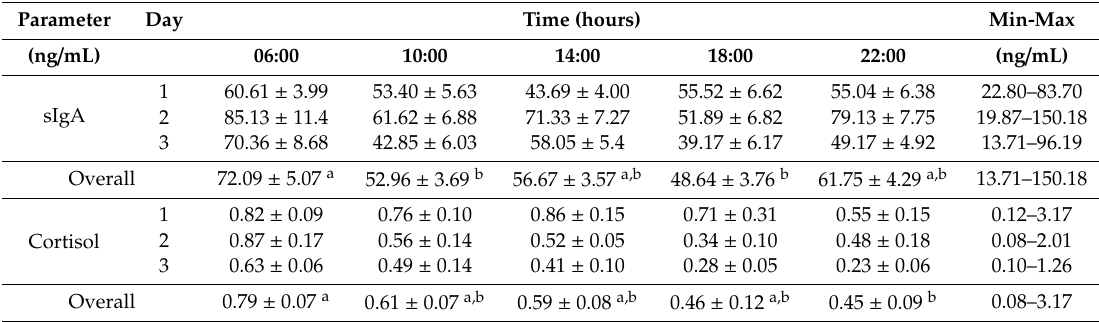
Table 1. Daily and overall mean ± standard error of the mean (SEM) concentrations and ranges of salivary immunoglobulin A (sIgA) and cortisol in 10 Asian elephants (n = 5 male, 5 female).